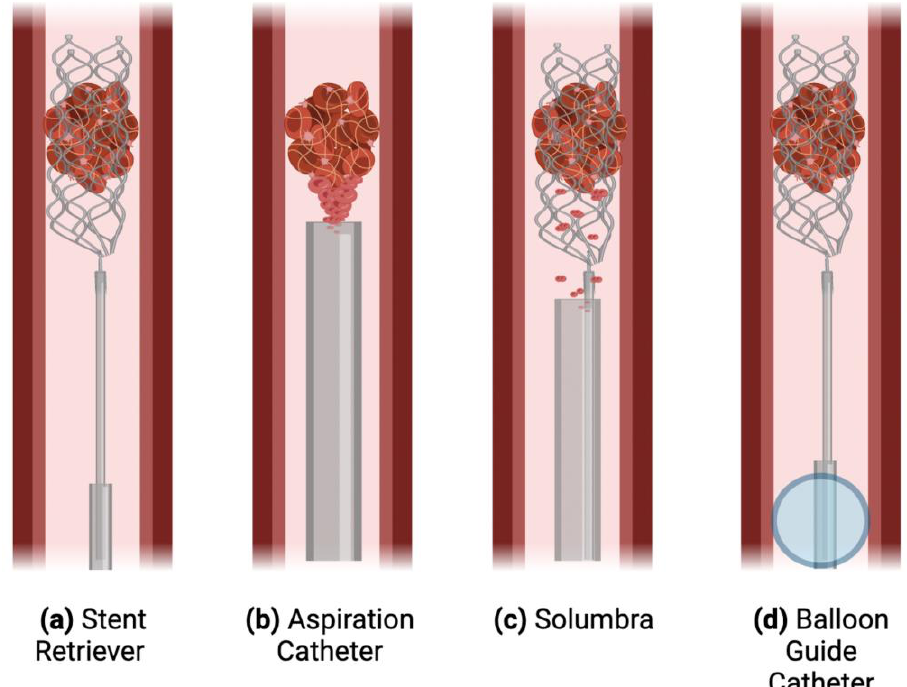
Figure 1. Various techniques used in endovascular thrombectomy. A schematic displaying four techniques: ( a ) The stent-retriever technique in which an aspiration catheter (e.g., a catheter with an inner diameter (ID) of 0.060” or 0.070”) is inserted through the femoral or radial artery and guided up to the specific vessel (e.g., approximately 2.5–3.0 mm in the M1 segment of the middle cerebral artery (MCA)) blocked by the clot. The guidewire and microcatheter cross the clot, and the stent is unsheathed and integrated with the clot, providing immediate reperfusion in most cases. Then, the stent and microcatheter are retrieved, ideally along with the clot [26]. ( b ) Aspiration catheters, which are larger than a microcatheter but not a fully deployed stent retriever, aspirate the clot in order to remove it from circulation [27]. ( c ) The Solumbra technique utilizes both the above techniques, simultaneously aspirating and using a stent to retrieve the clot. ( d ) A balloon guide catheter can be inflated in place in the vessel, stopping antegrade blood flow and causing brief retrograde flow, diminishing the risk of distal embolization. Adapted from Munich et al. (2019) [26].